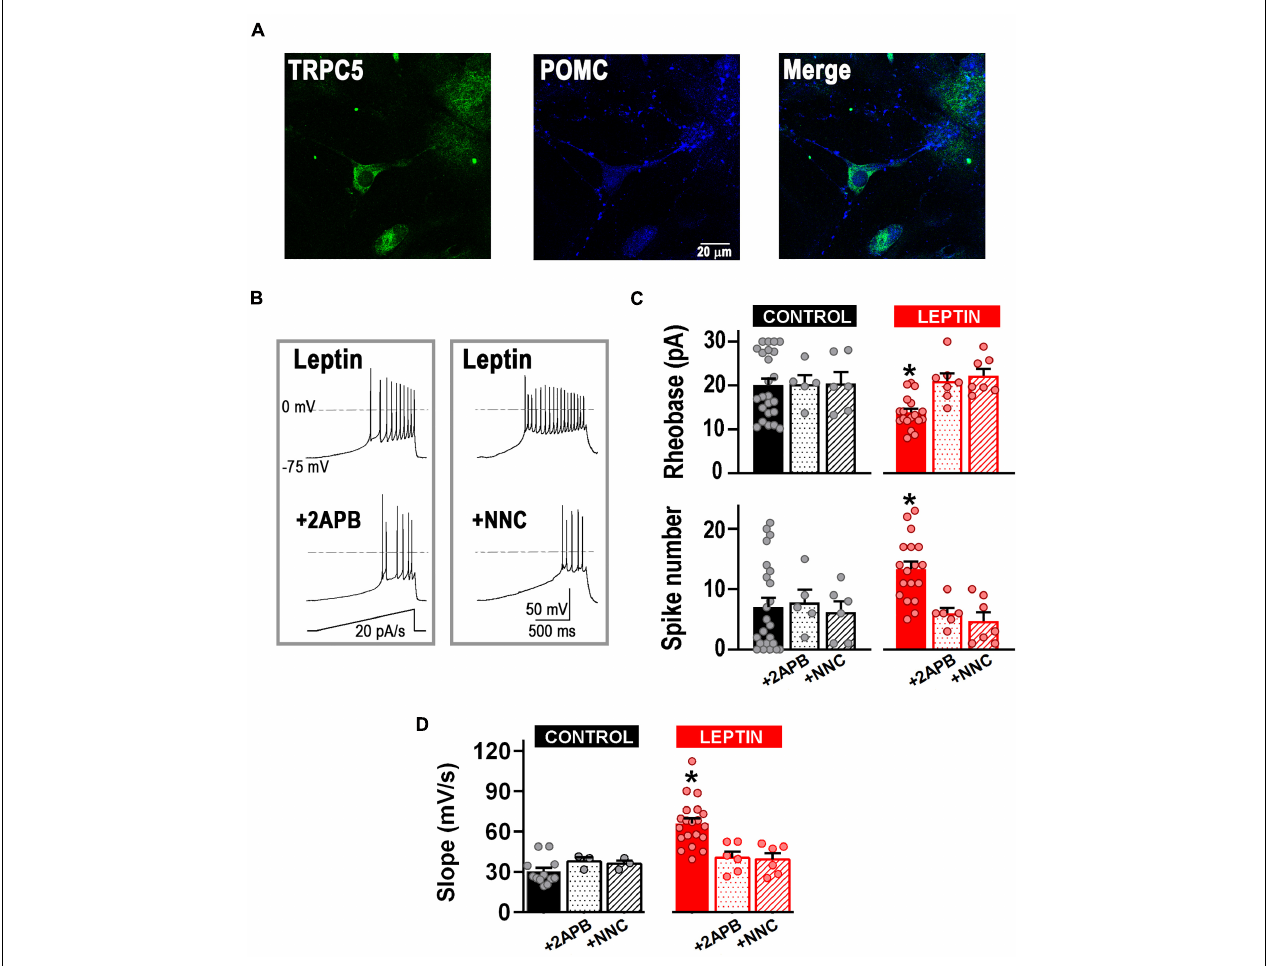
FIGURE 4 | T-type calcium channels are necessary for the leptin-induced excitability response. (A) Example of fluorescence images showing the expression of TRPC5 channels (green) in POMC neurons (blue). (B) Examples of neuronal firing elicited from a preset membrane potential of –75 mV by a 20 pA/s ramp in leptin-treated neurons before and after the addition of the TRPC channel blocker 2-APB (100 µ M) or the T-type channel blocker NNC 55-0396 (10 µ M). (C) Quantification of rheobase (pA) and number of action potentials in control neurons ( n = 24), neurons treated with the TRPC channel blocker 2-APB (100 µ M, n = 5), neurons treated with the T-type channel blocker NNC 55–0396 (10 µ M, n = 6), neurons treated with leptin (100 nM, n = 18), neurons treated with leptin and 2-APB (n = 5), and neurons treated with leptin and NNC 55-0396 (10 µ M, n = 7). *Significantly different from all others, P < 0.05, ANOVA, F ( 5 , 61 ) = 3.786 (for rheobase), F ( 5 , 61 ) = 3.856 (for AP number). (D) Quantification of the rate of membrane potential depolarization (slope) in control neurons ( n = 12), neurons treated with the TRPC channel blocker 2-APB (100 µ M, n = 3), neurons treated with the T-type channel blocker NNC 55-0396 (10 µ M, n = 3), neurons treated with leptin (100 nM, n = 20), neurons treated with leptin and 2-APB ( n = 6), and neurons treated with leptin and NNC 55-0396 (10 µ M, n = 6). *Significantly different from all others, P < 0.05, ANOVA, F ( 5 , 44 ) =